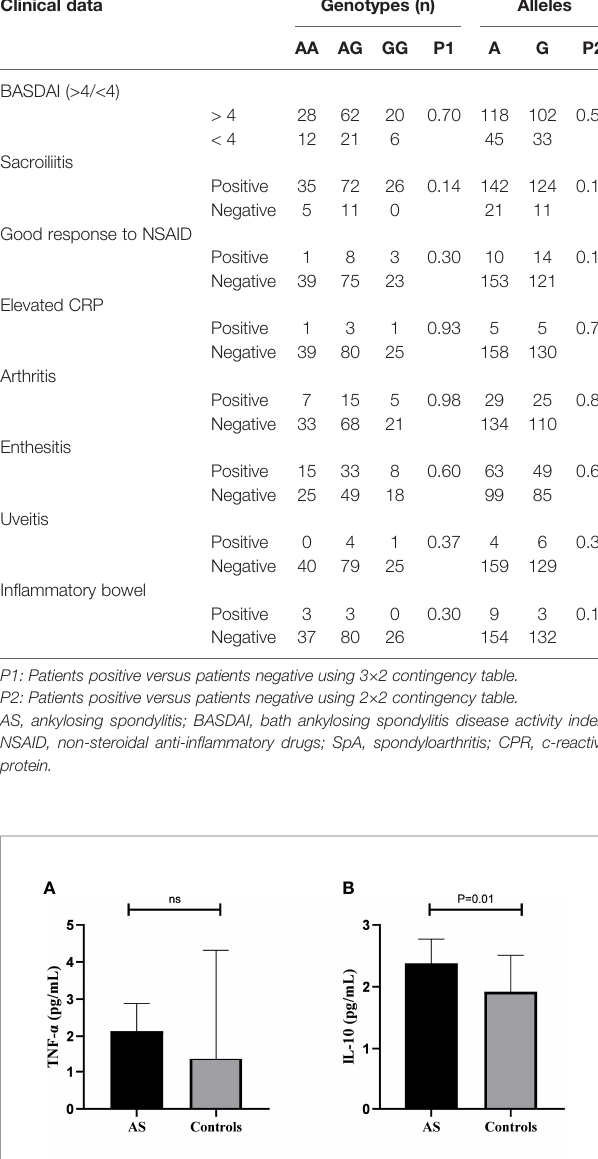
A+A/A and 1.39 (IQR, 1.37) pg/ml for G/G ( Figure 3B ). Serum levels of IL-10 in AS patients carrying IL10 rs1800896 A/G +A/A were 2.38 (IQR, 0.45) pg/ml and 2.77 (IQR 0.91) pg/mL in those carrying A/A ( Figure 3C ); for controls carrying A/G +A/A, it was 1.58 (IQR, 0.68) pg/ml and for A/A 2.12 (IQR 1.19) pg/ml ( Figure 3D ). Serum levels of IL-17A were 26.00 (IQR, 51.6) pg/ ml in AS patients carrying the IL17A rs2275913 G/A+A/A genotypes and 15.63 (IQR, 49.6) pg/ml for those carrying the G/G genotype ( Figure 3E ); for controls, it was 94.63 (IQR,